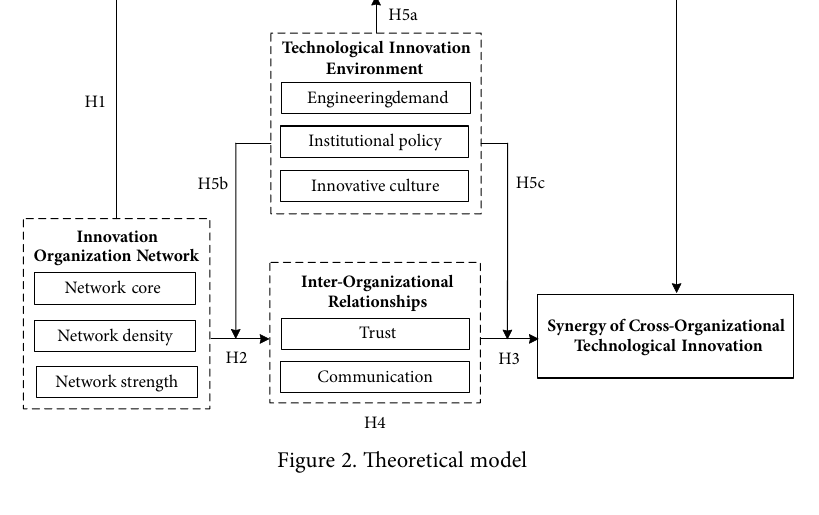
Figure 2. Theoretical model